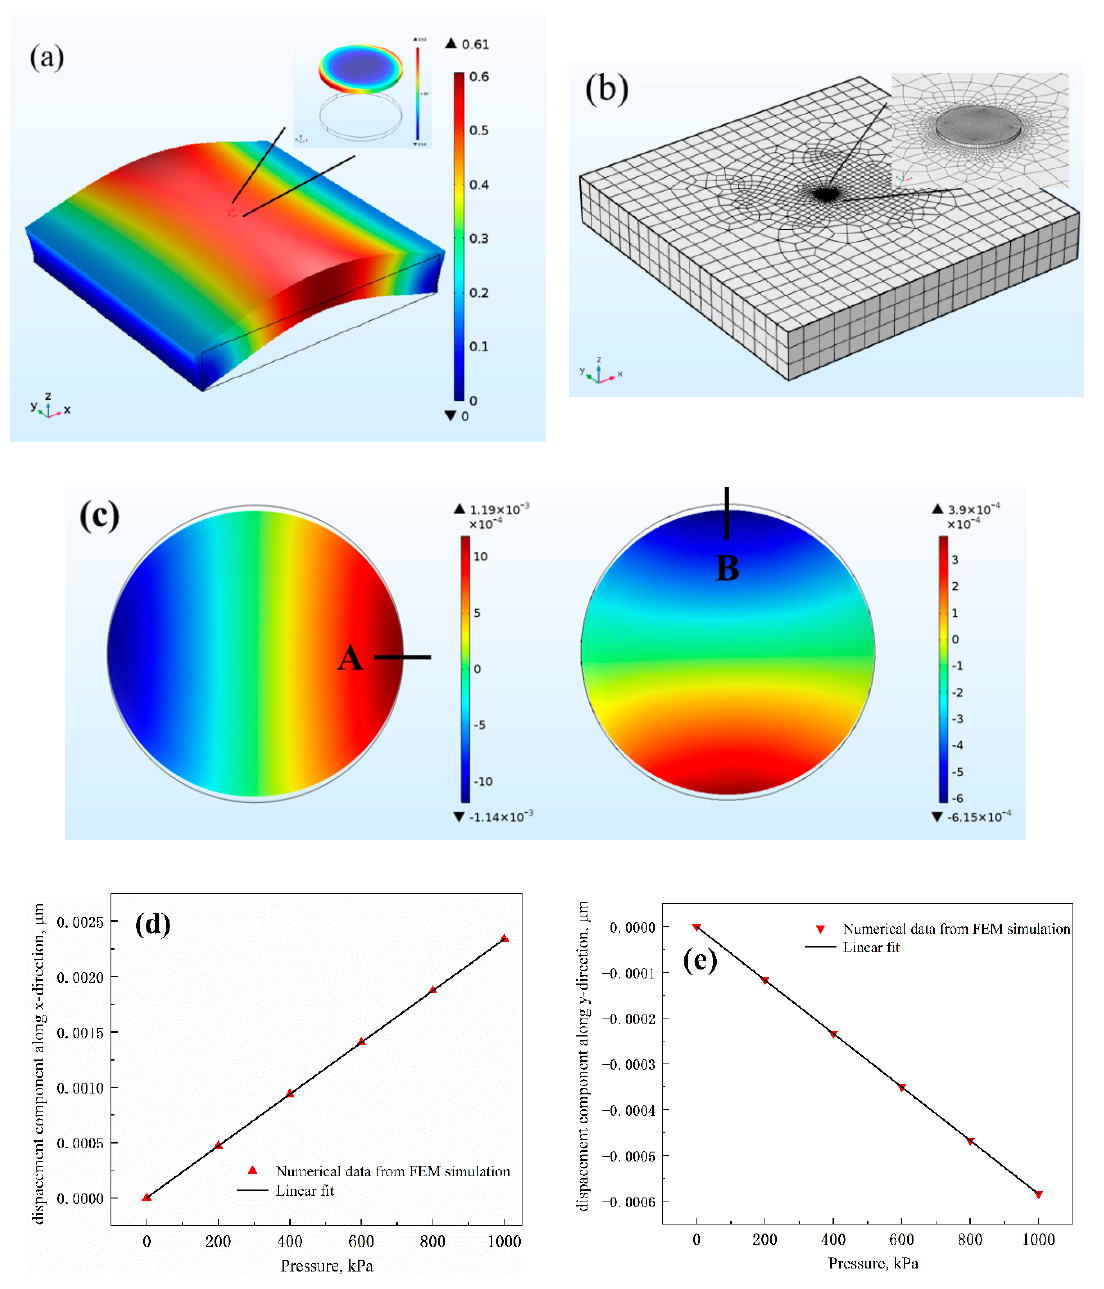
Figure 7. ( a ) The displacement of the substrate and the enlarged insert of MDR under a pressure of 600 kPa. ( b ) Mesh generation of the simulation model. ( c ) The displacement component distribution for the MDR in x and y direction. The x direction displacement component at point A, ( d ) and the y direction displacement component at point B ( e ) versus pressure.